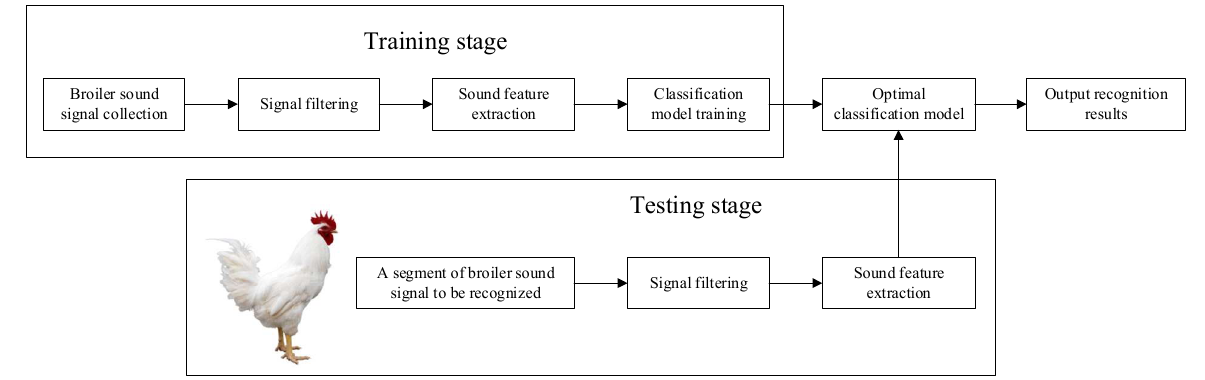
Figure 1. Research process of broiler sound signal recognition